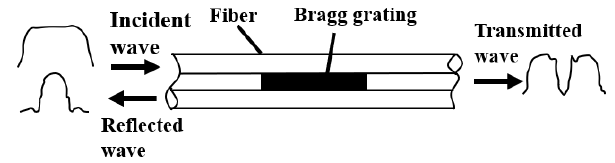
Figure 1. Working principle of fibre Bragg grating.